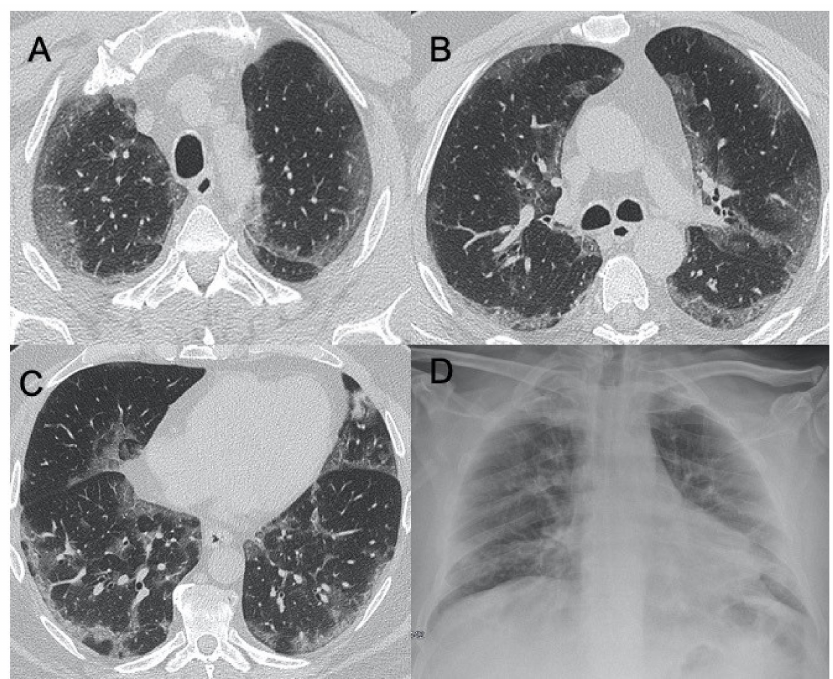
Figure 3. Influenza A. Figures in ( A – C ) show a case of influenza A with an interstitial pattern very similar to COVID-19: ground-glass opacities are mainly subpleural and bilateral, with a peri-lobular pattern of distribution. Figure ( D ) is a supine chest radiograph of the same patient, with diffuse interstitial